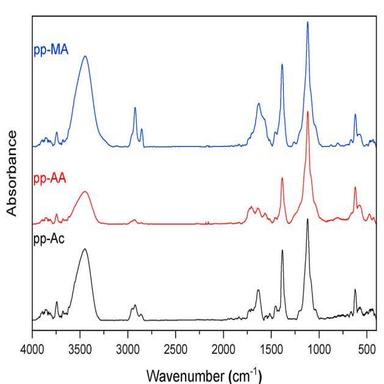
FTIR spectra of pp-Ac, pp-AA, pp-MA prepared in optimal operating parameters.